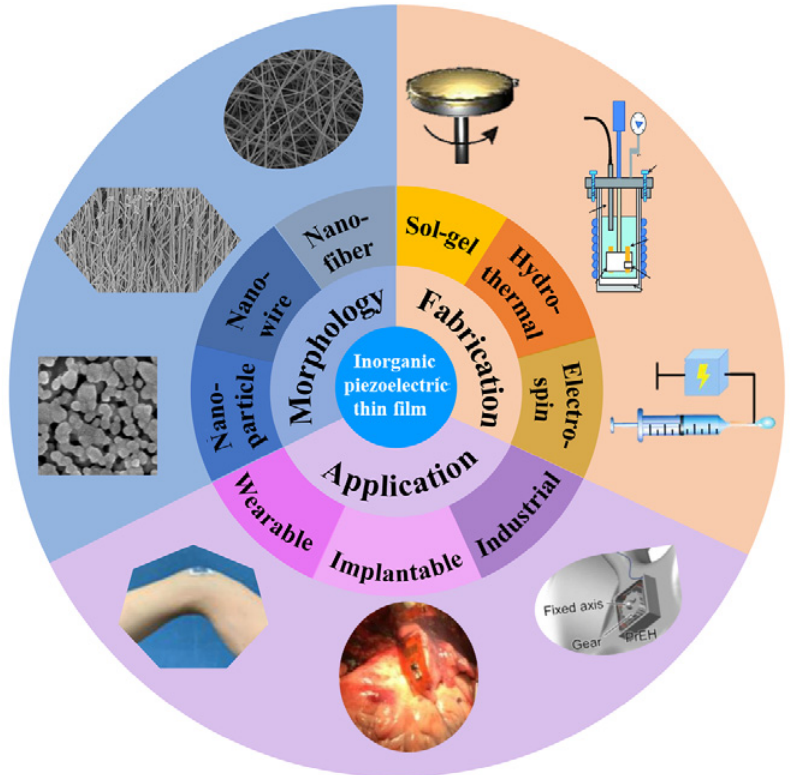
Fig. 1 Summary of flexible inorganic piezoelectric thin films in structure, fabrication, and